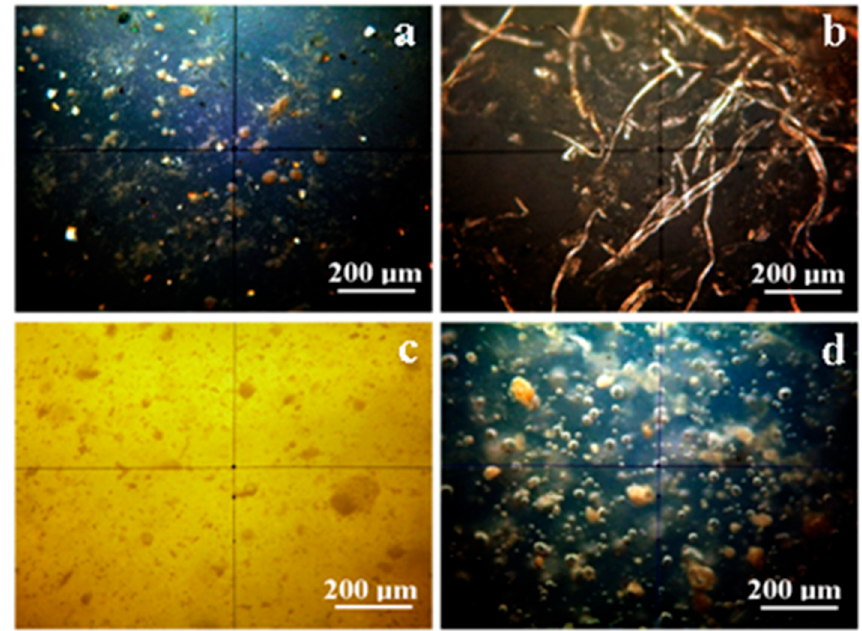
Figure 1. PLM images of the thin slices of the samples: ( a ) Adoro; ( b ) Variolink; ( c ) Relyx and ( d ) Solidex.